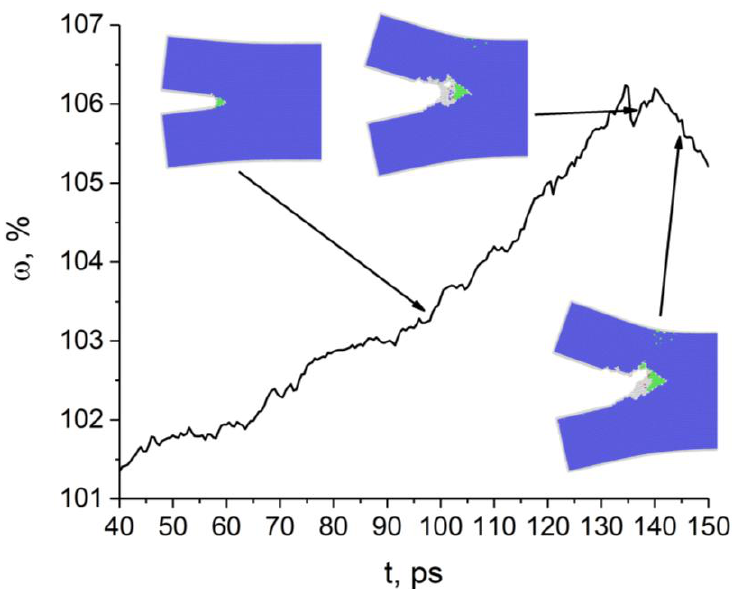
Figure 3. Time variation of atomic volume at the tip of the (010)[100] crack. Atoms with bcc, fcc, and uncertain nearest neighbor symmetry are colored blue, green and gray, respectively.